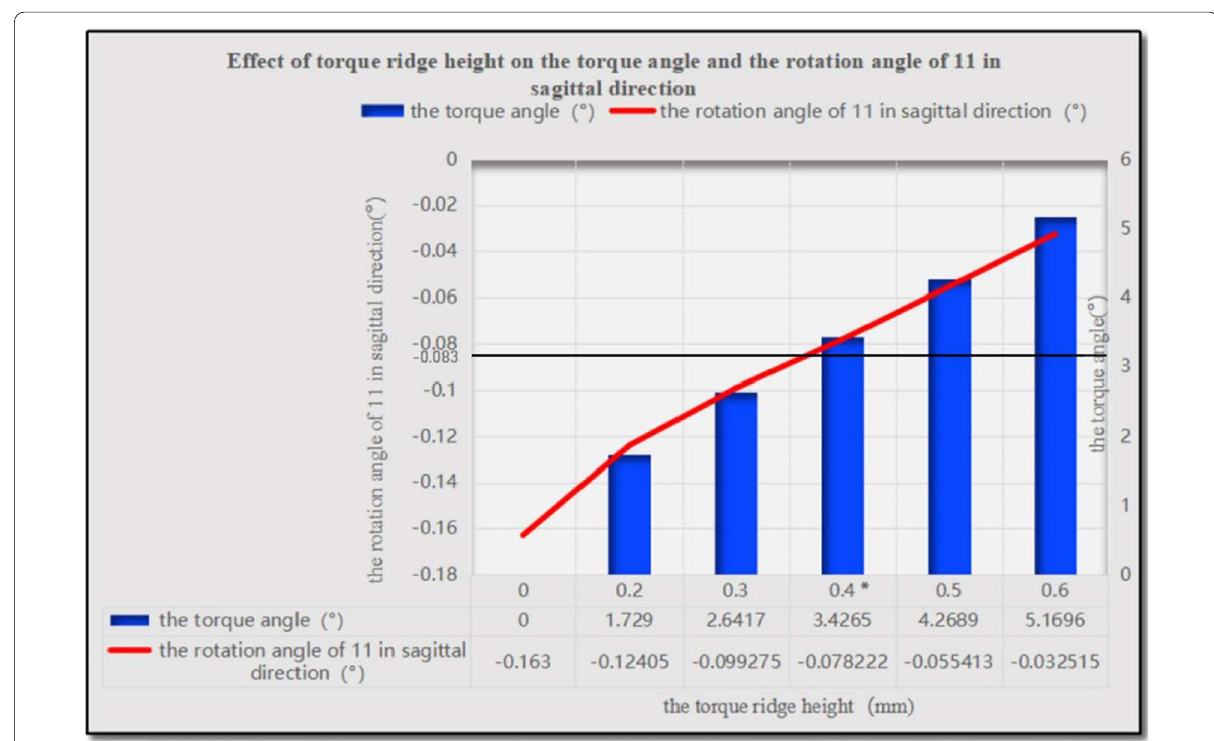
Fig. 6 The rotation angle of 11 in the sagittal direction with different power ridge heights when the axial inclination of 11 was 110°. *When the height of the power ridge was 0.4 mm, the rotation angle of the upper central incisor was 0.078222° in the sagittal plane, which was very close to 0.08333°. That is, the axial inclination of an upper central incisor would decrease to 105° after the completion of anterior retraction